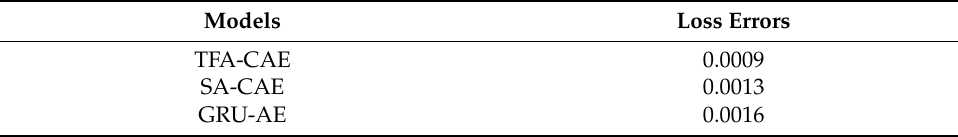
Table 3. Comparison of the loss values of TFA-CAE, SA-CAE and